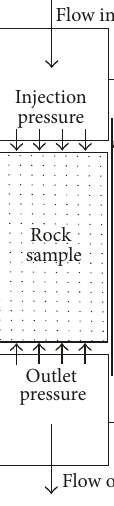
Figure 2: Schematic diagram of permeability